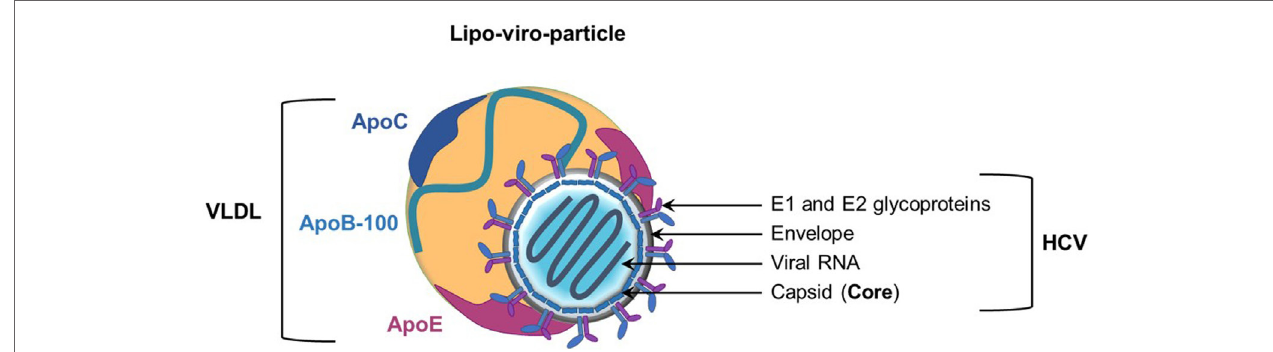
FigURe 1 | Model of the hepatitis C virus (HCV) lipo-viro-particle (LVP). The HCV particle consists of an icosahedral capsid, formed by the viral core protein, containing the positive-stranded viral RNA. The nucleocapsid is surrounded by an endoplasmic reticulum-derived envelop in which E1 and E2 glycoproteins are embedded. The highly infectious HCV particle corresponds to a hybrid particle composed of very-low-density lipoprotein (VLDL) components and viral components named LVP. The different apolipoproteins classically associated with VLDL and LVP are illustrated on this picture (ApoB-100 and the exchangeable apolipoproteins ApoE and